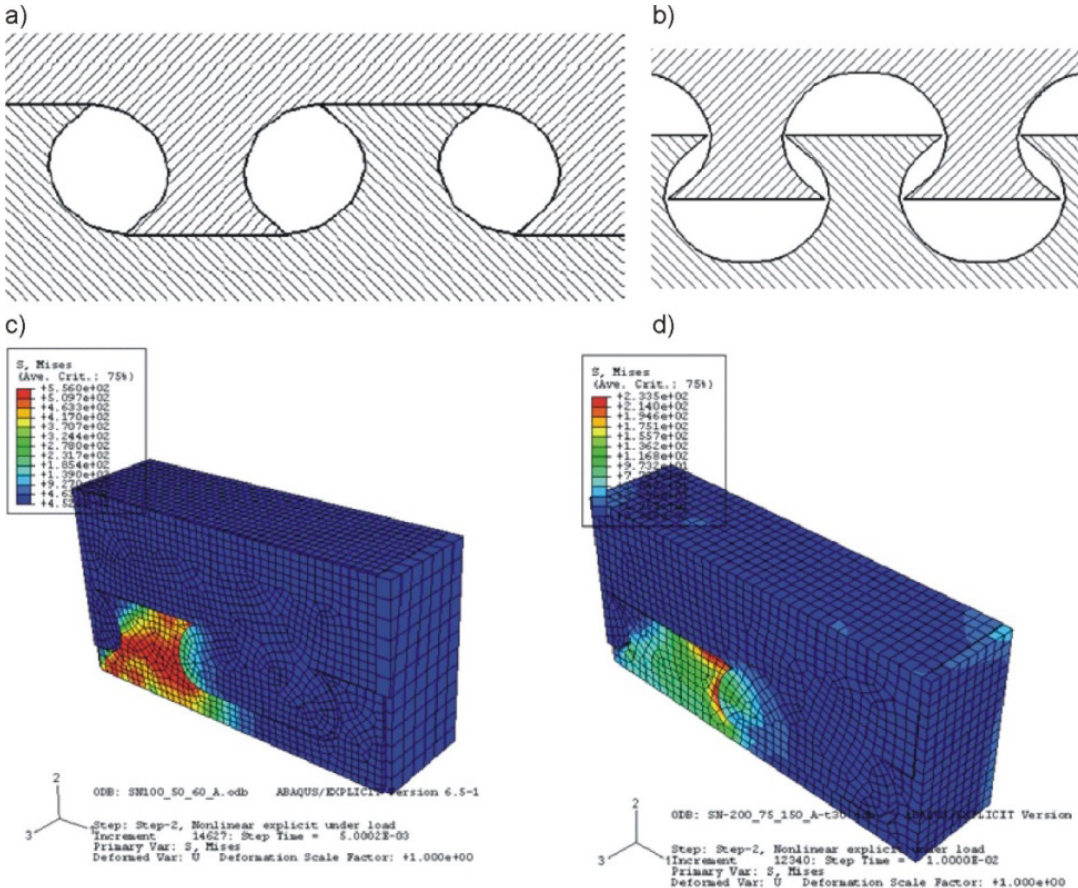
Figure 24: Study of the SN shape: a) the basic idea of cutting, b) modification of cutting to achieve a stronger steel part compared to the concrete part, c) reduced stress layout for the chosen geometry of the SN shape (short steel dowel) with steel web thickness equal to 10 mm (steel failure), and d) reduced stress layout for the chosen geometry of the SN shape (long steel dowel) with steel web thickness equal to 30 mm (concrete